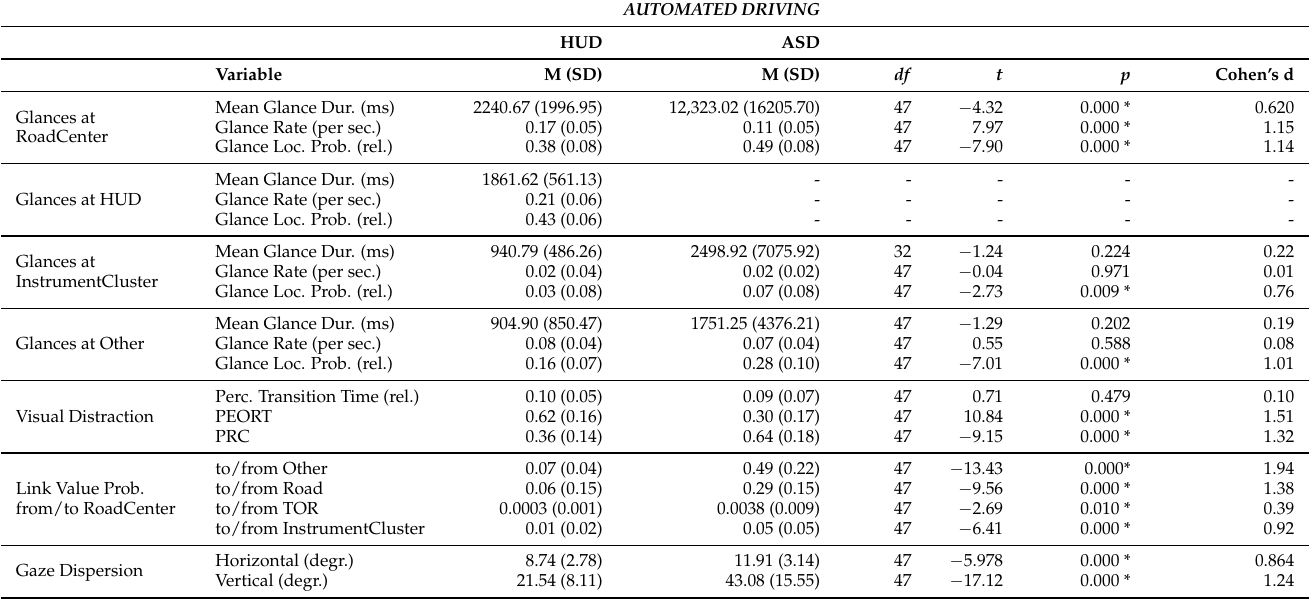
Table 1. Descriptive statistics of visual behavior measures during automated driving in the conditions heads-up display (HUD) and auditory speech display (ASD). We report the mean (M), standard deviation (SD), t -test statistics, and effect sizes (Cohen’s d). AoI driving mode display (DMD) was excluded from the AoI-specific analysis due to the low number of samples observed.